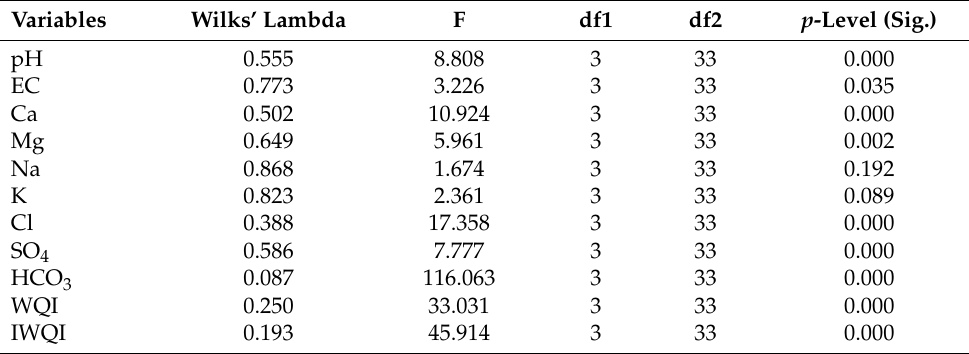
Table 7. Tests of group mean quality for discriminant analysis.